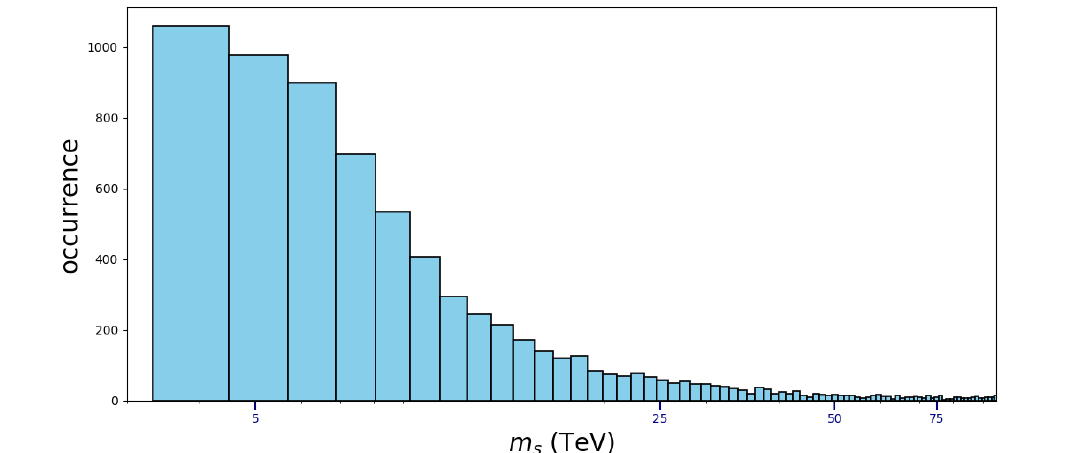
Figure 2 . Histogram showing the probability distribution of the minimum required sfermion mass, m S that satis(cid:12)es the proton lifetime bounds. We allow the range 3 TeV Wino mass, m W = 1